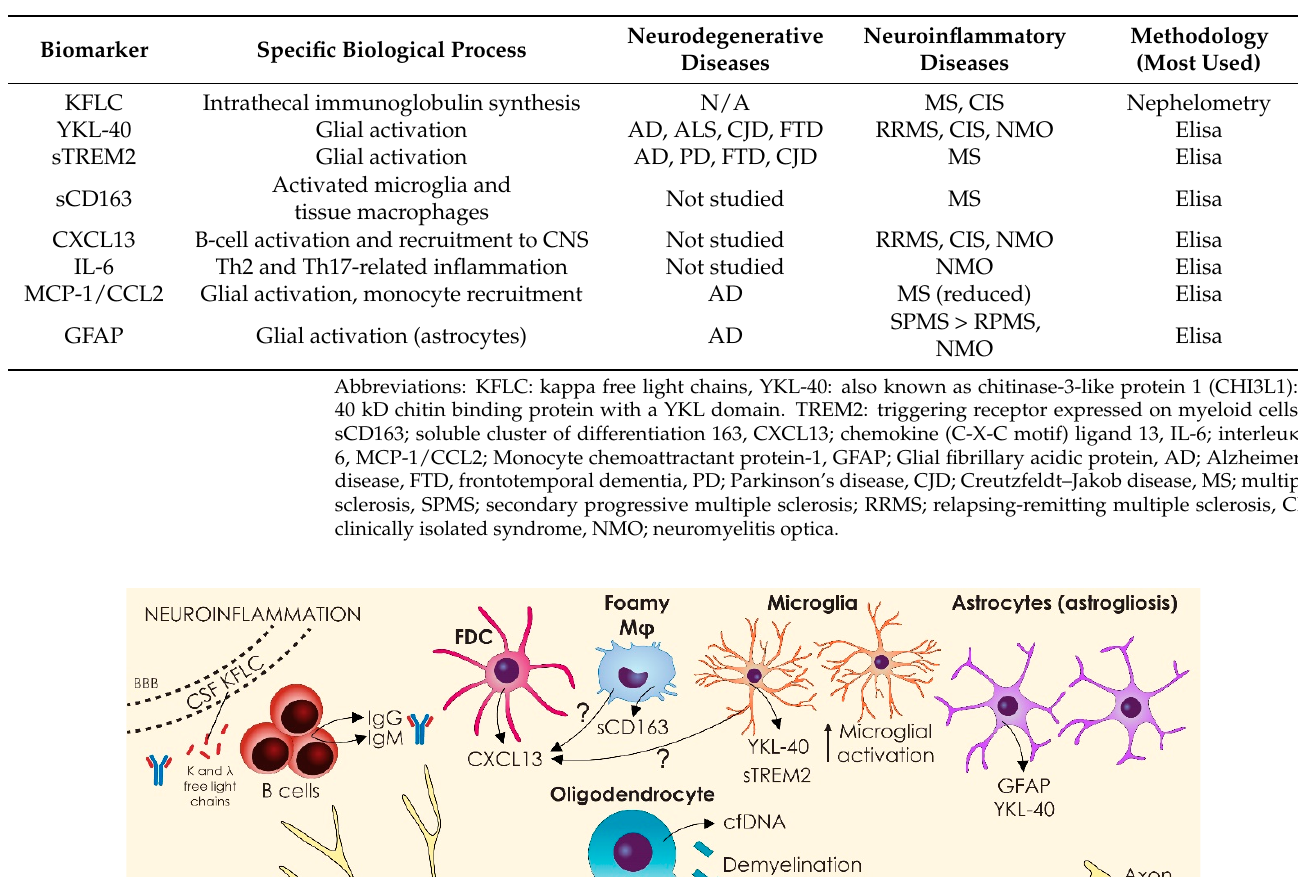
Table 1. CSF-based biomarkers tracking neuroinflammation.